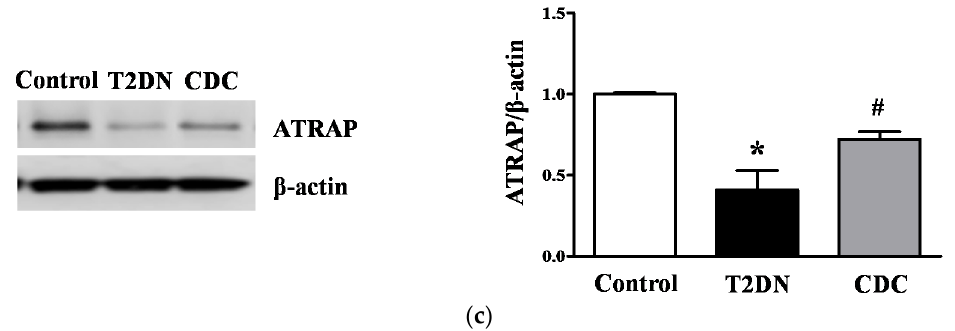
Figure 7. Effect of 12-LO on the AT1R and ATRAP protein expression in glomeruli of type-1 and type-2 diabetic rats. Glomerular AT1R and ATRAP expression was determined by Western blot. ( a ) AT1R protein expression in glomeruli of control, type-1 diabetic rats and CDC-treated rats; n = 10 in each group; ( b ) total AT1R and membrane AT1R protein expression in glomeruli of control, type-2 diabetic rats and CDC-treated rats; n = 20 in each group; ( c ) ATRAP protein expression in glomeruli of control, type-2 diabetic rats and CDC-treated rats; n = 20 in each group. Data are presented as the mean ± SD of three independent experiments; * p < 0.01 vs. the control; # p < 0.05 vs. T2DN.